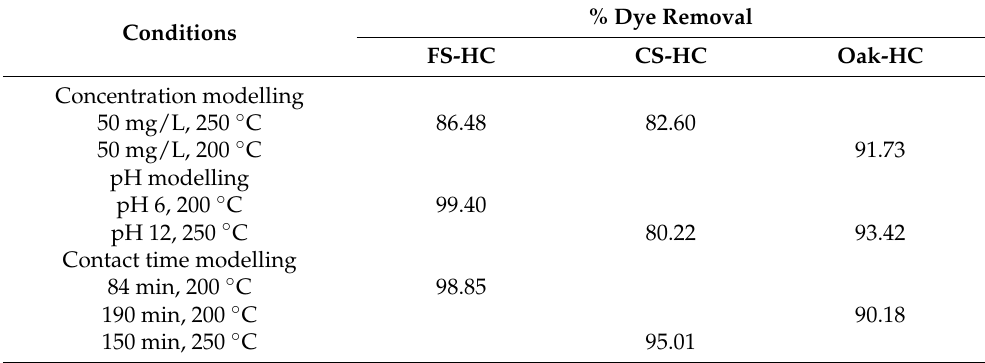
Table 3. Optimisation of adsorption conditions and HTC